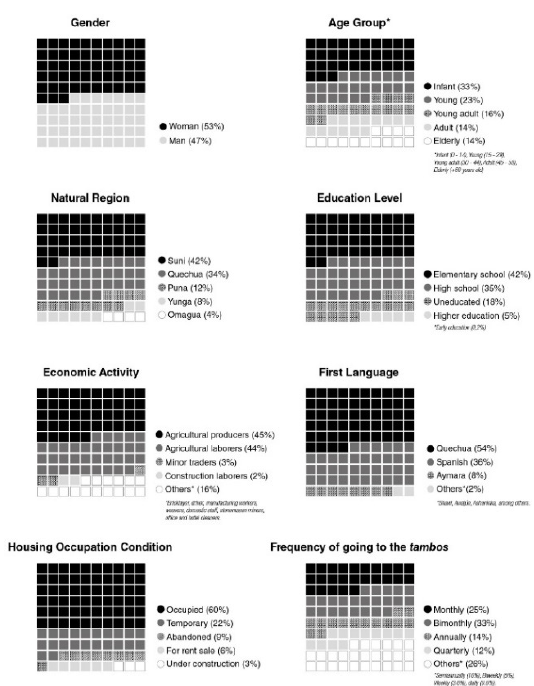
Figure 4. The location rules and influence area of the tambos (source: author, elaboration based on MIDIS, 2017)